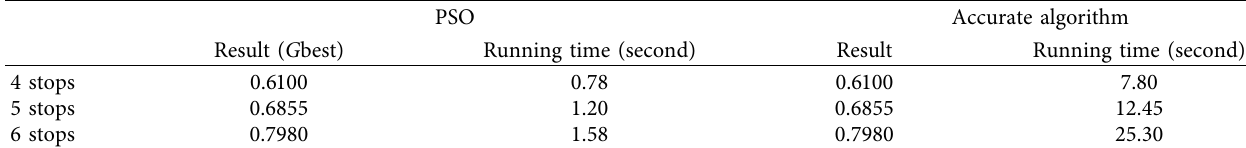
Table 9: Computational results of different algorithms.